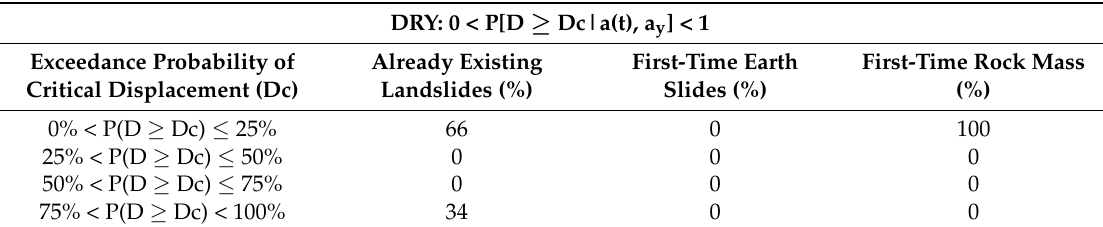
Table 5. Results obtained in terms of exceedance probability for the middle saturation scenario (RT = 475 year).